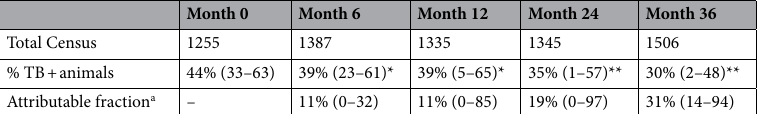
Table 1. Overall evolution of TB status of farms 1, 2, 3 and 5 throughout 36 months of vaccination trial. a Attributable Fraction: Percentage of prevalence reduction between prevalence at M0 and the prevalence at subsequent samplings. Ranges are shown in parenthesis. * P < 0,05. ** P < 0,001. Chi square test. Significant differences respect to the initial proportion of positive animals at